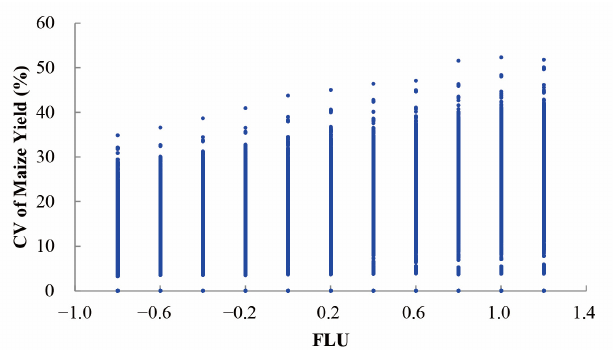
Figure 7. Statistical distribution of the CV of maize yield on each FLU level in the study area.